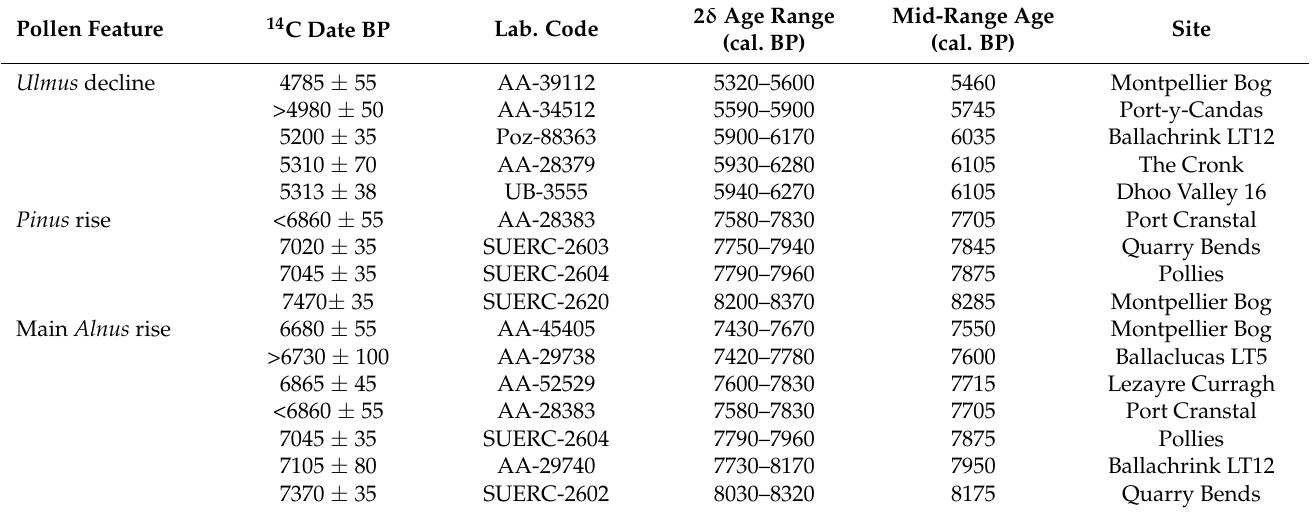
Table 1. Radiocarbon ages, including limiting dates, for major Isle of Man early and mid-Holocene tree pollen stratigraphic events. Dates are AMS on peat, except Dhoo Valley 16 (radiometric). Age ranges (2 δ ) and the mid-range age are derived from calibration results using Oxcal 4.4 and IntCal20